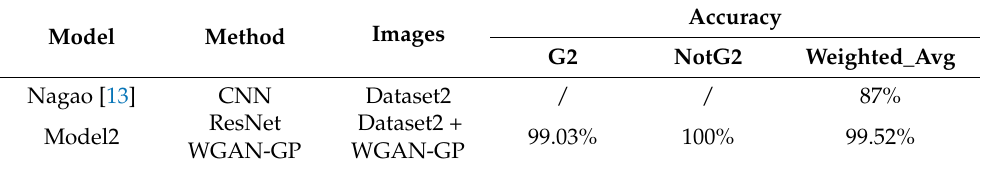
Table 12. The two-class classification accuracy on the same dataset (Hela